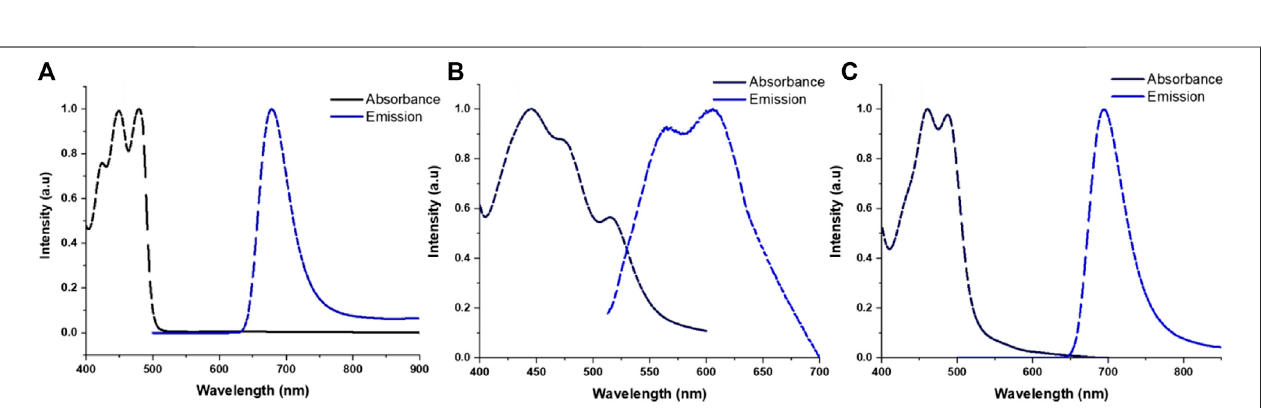
FIGURE 3 | Normalized absorbance and emission pro fi les for TRPZ-PG (A) in THF, TRPZ-127 NPs (B) and TRPZ-bisMPA NPs (C) in Milli-Q water.